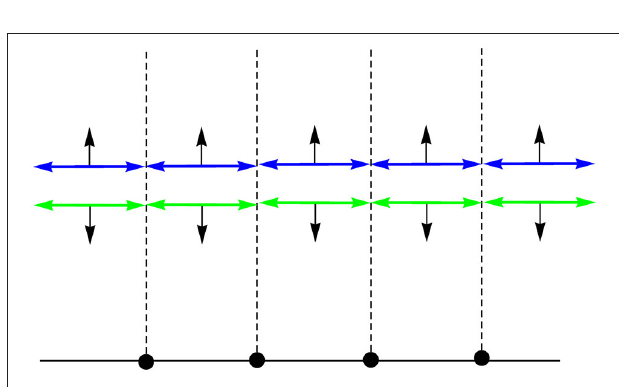
X 4 filter intensity for different values of r . −